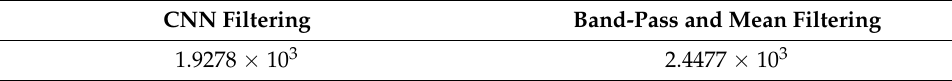
Figure 16. Detailed spectra comparison between the CNN filtering result and the combined band-pass and mean filtering result. Table 2. Mean integral relative error comparison of the filtering results in Figure 12d, e .